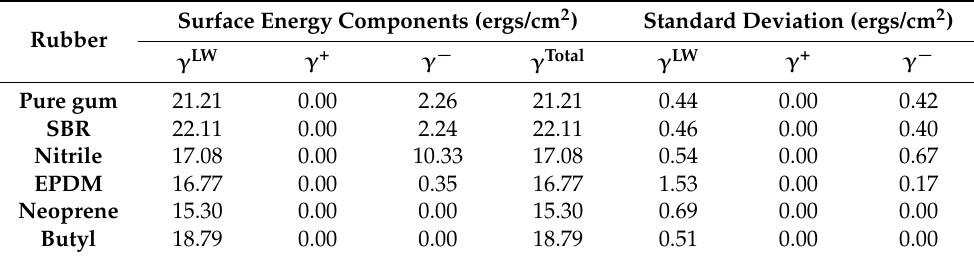
Table 5. Measured surface energy of rubber materials using the Sessile drop device.